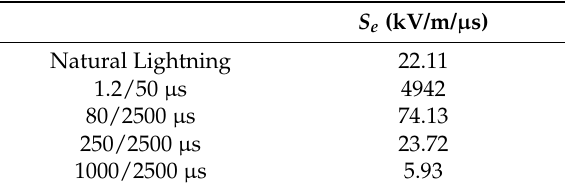
Table 1. Comparison of variation under different wavefront